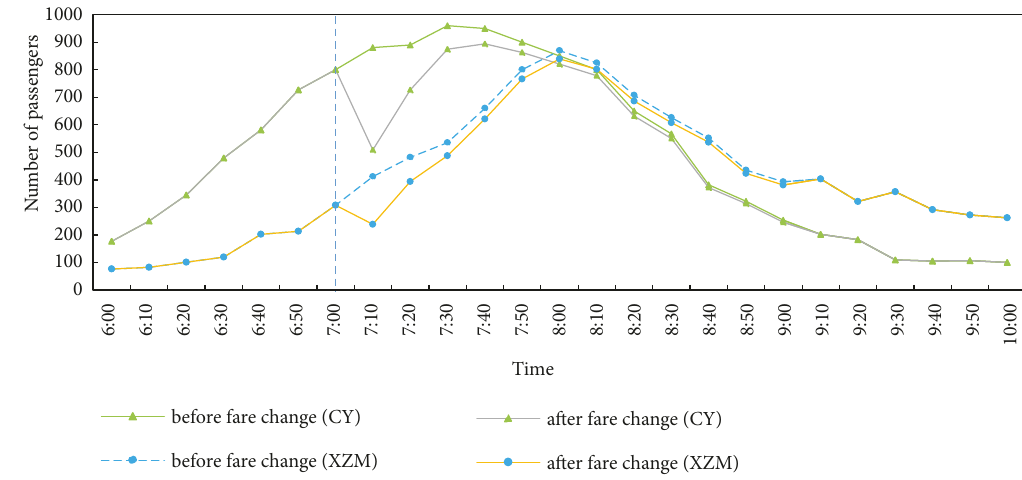
Figure 15: Estimated changes in peak demand after the 50% discount fare policy with the end time of 7:00